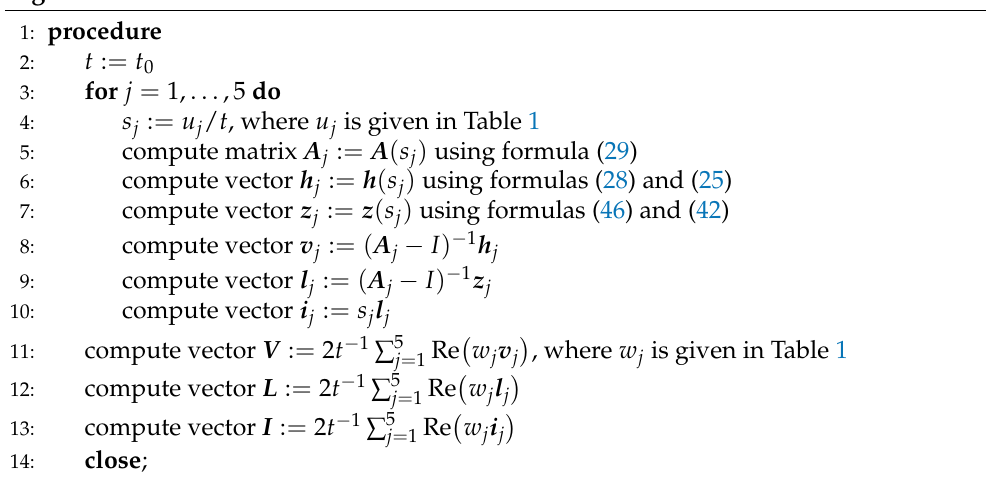
Algorithm 1 Transient characteristics